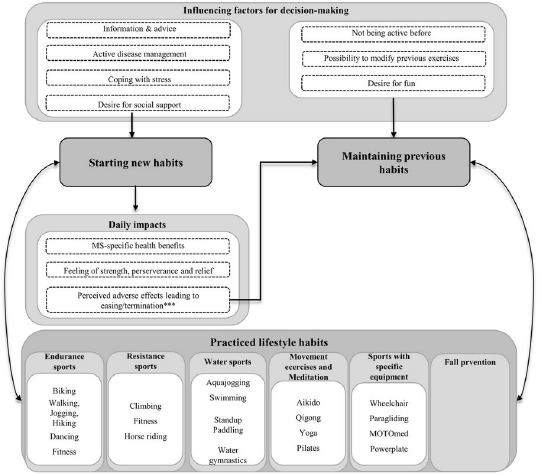
Fig 2. Sub-themes of exercise and physical activity. ��� Perceived deterioration while starting new habits resulted in the resumption of previous habits before the diagnosis of